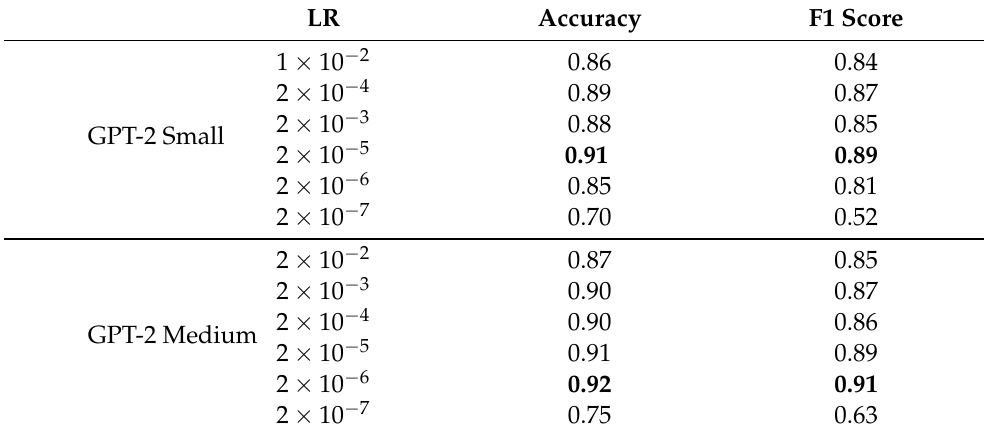
Table 6. Fine-tuning GPT-2 small and medium.